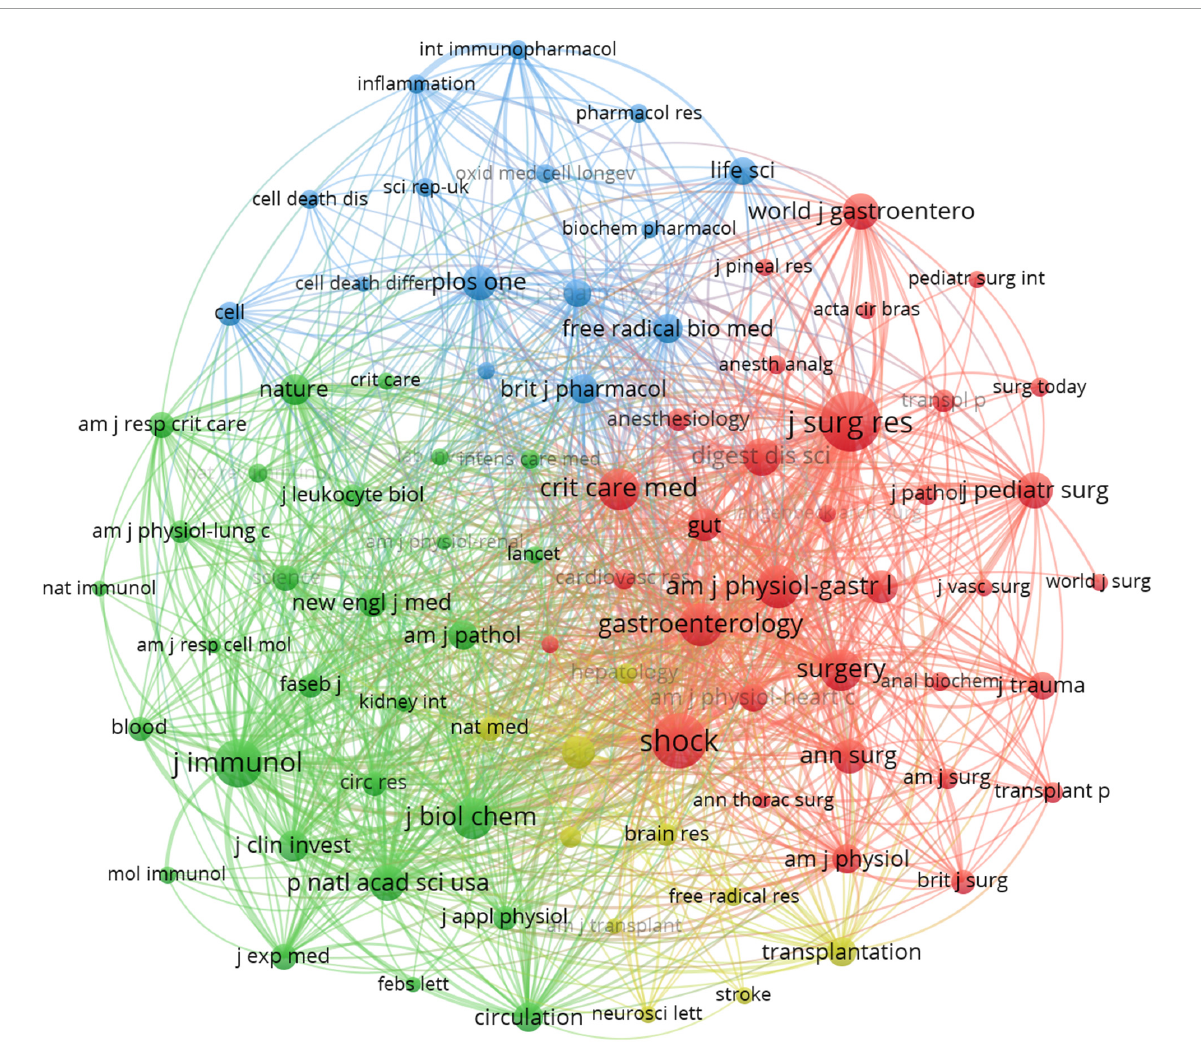
FIGURE5 Visualization of the relationship between co-cited journals. One node represents one journal, and the area means the citation frequency. Sizes of nodes are reflected with